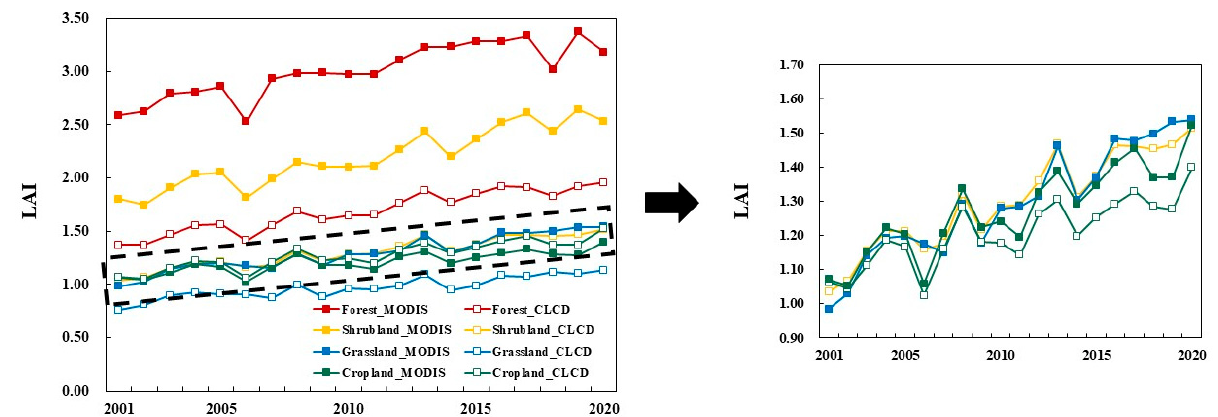
Figure 3. The growing season average LAI of four landcover types in the Beijing–Tianjin—Hebei region using two classification criteria of MODIS IGBP and CLCD.